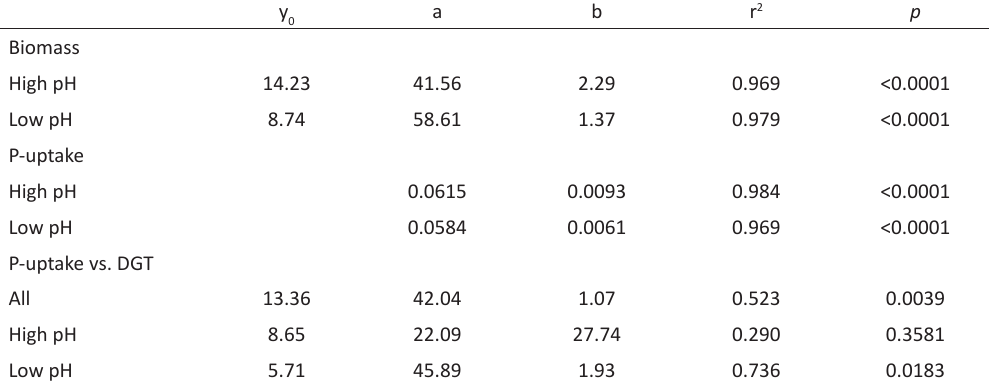
Table 3. Regression coefficients prediction of biomass and P uptake for calculation of mineral fertiliser equivalent (MFE), and prediction of plant P uptake based on DGT uptake y